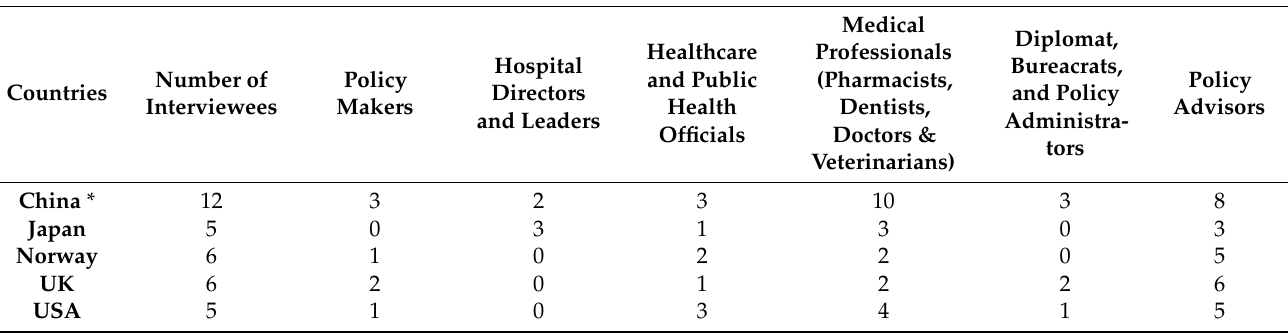
Table 2. Summary of interviewee profiles.